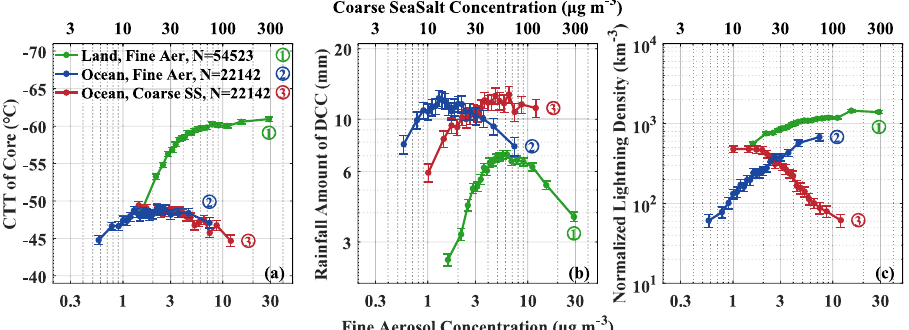
Fig. 2 Relationships between aerosols and deep concective cloud (DCC) properties. The dependence of the cloud top temperatures (CTTs) of convective core ( a ), domain-averaged rainfall amount (i.e., rainfall depth) throughout DCC lifetime ( b ), and lightning fl ashes per km 3 of rainfall ( c ) are given as a function of fi ne aerosol mass concentrations (bottom abscissa scale) over land (green lines) and ocean (blue lines). The red lines give the dependence on coarse sea salt (CSS) aerosol mass concentrations over ocean (top abscissa scale). The I-type vertical bars indicate standard error. The aerosol bins are at intervals of 5% of the cases. The total number of data points for each line is shown in the fi ne aerosols. This 25% difference may be ascribed to the ther- modynamic differences between land and ocean 12 . The lightning sensitivity is very high for low concentrations of fi ne aerosols and tends to saturate at high aerosol concentrations. The fi ne aerosol concentration span between the 5% to 95%